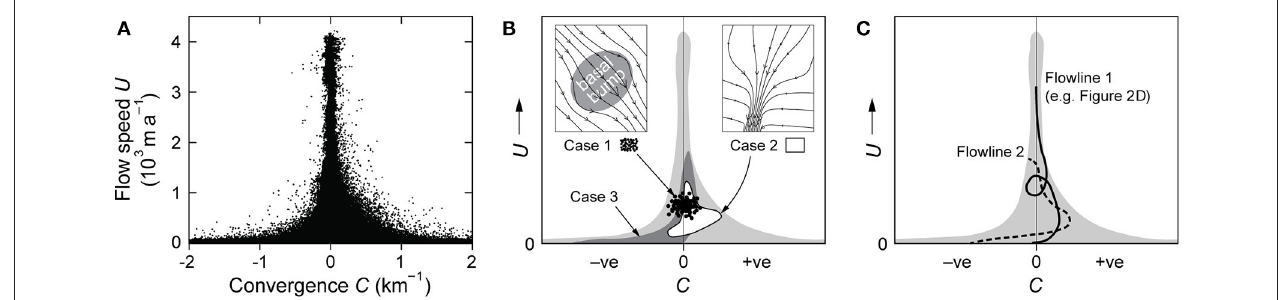
FIGURE 3 | Different ways of decomposing the tower distribution. (A) Plot of U versus C for the Antarctic Ice Sheet; data from Ng (2015). (B) Hypothetical U – C data associated with different ice-flow structures, overlaid on the tower distribution from panel (A) ; cases 1 to 3 are explained in the text. (C) Hypothetical trajectories of U and C along two